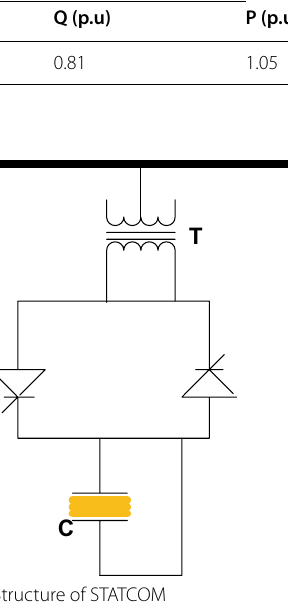
Table 20 Power flow comparison with and without presence of TSC at bus 4 of IEEE 9- bus system Bus No Without TSC With TSC Heuristic pdf